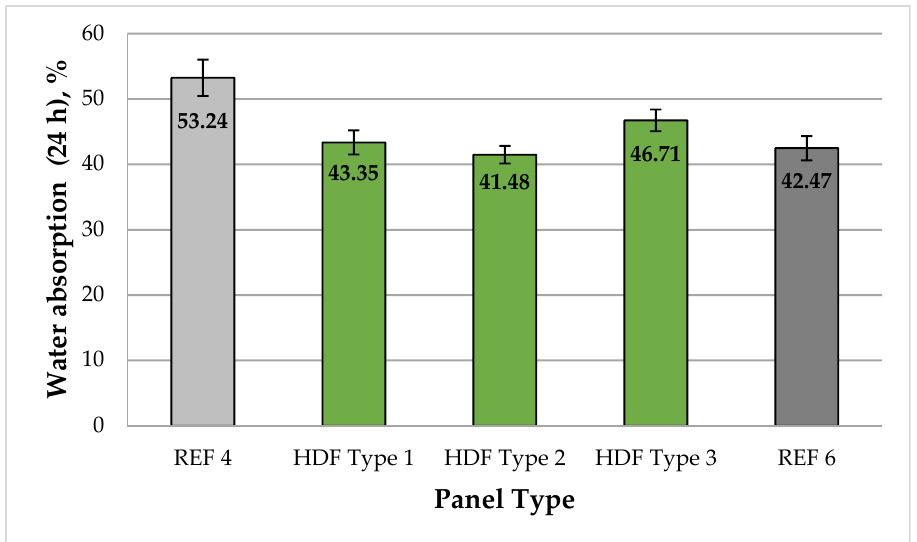
Figure 2. Water absorption (24 h) of the HDF panels produced. REF 4: 4% UF resin; HDF Type 1: 4% UF resin and 4% ALS; HDF Type 2: 4% UF resin and 6% ALS; HDF Type 3: 4% UF resin and 8% ALS; and REF 6: 6% UF resin. (Error bar represents the standard deviation.).